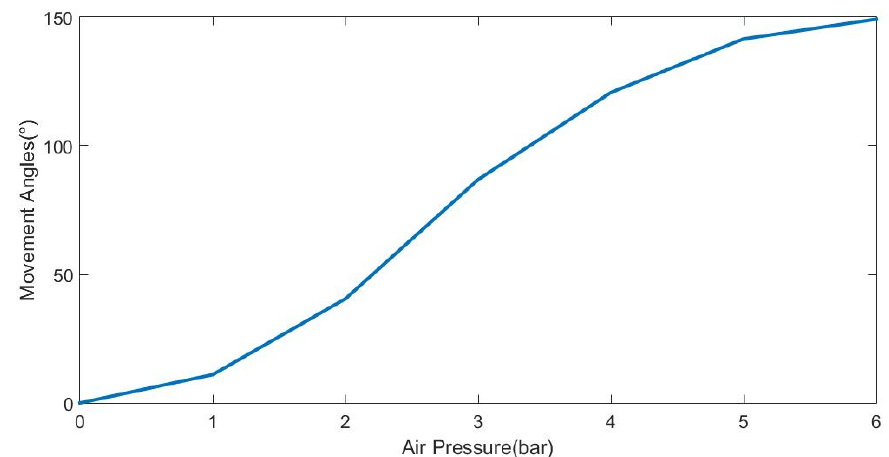
Figure 3. Movement angles as a function of air pressure.